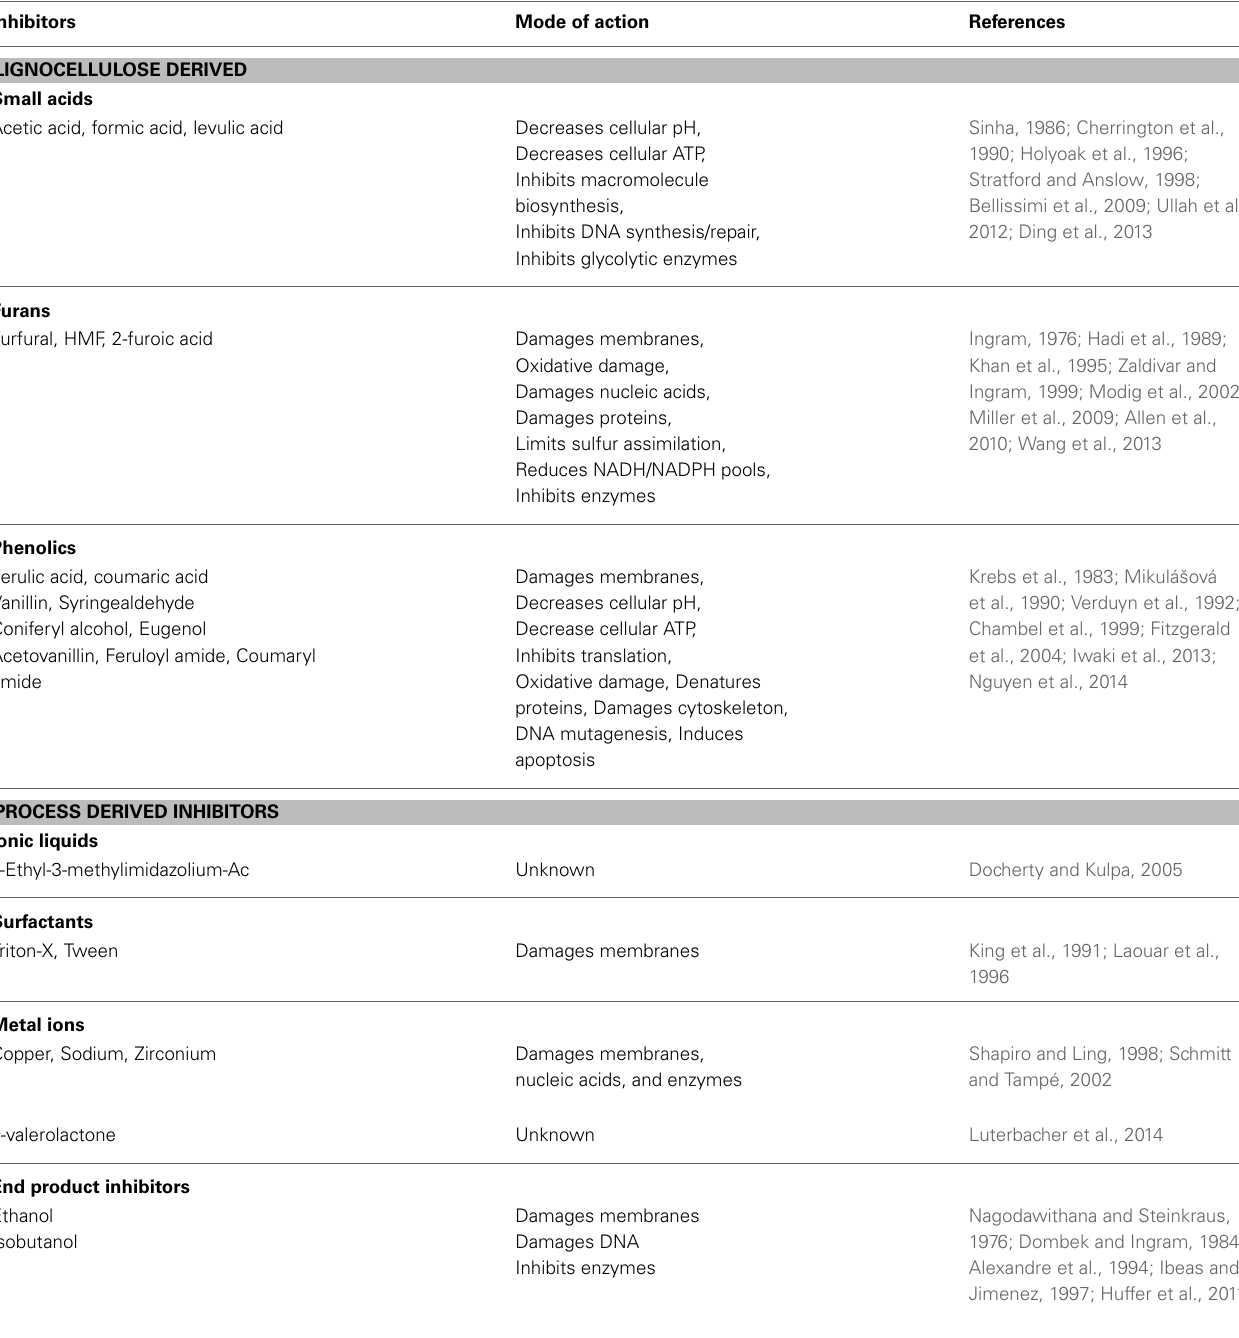
Table 1 | Classes of lignocellulosic hydrolysate (LCH) inhibitors and their described modes of toxicity.